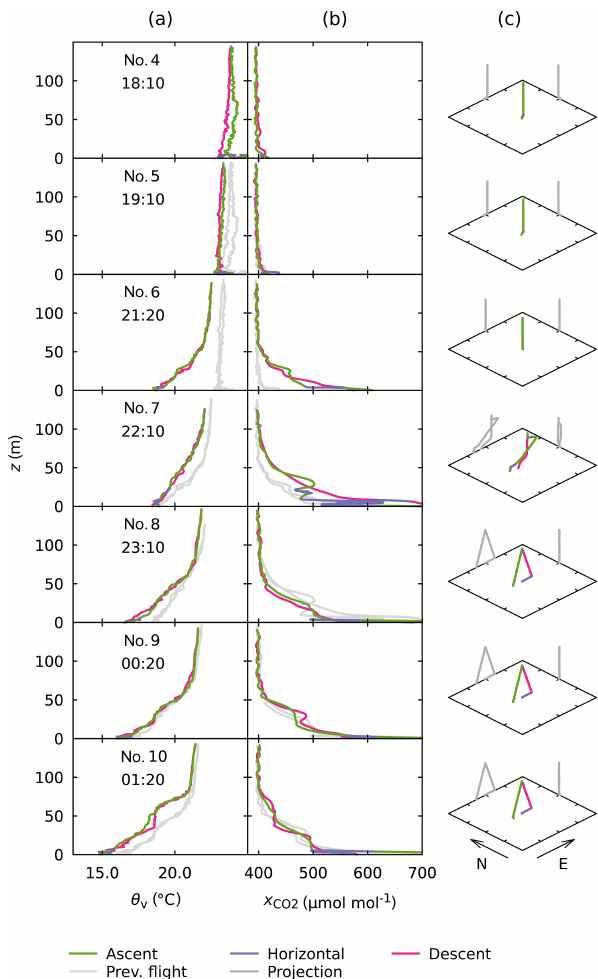
Figure 7. Profiles from flights 4 through 10, carried out in the night from 6 to 7 July 2016. Times are given in Coordinated Univer- sal Time and specify the middle of the flight, rounded to the next 10min. (a) Virtual potential temperature θ v at height above ground level z . (b) Carbon dioxide dry-air mole fraction x CO at height 2 above ground level z . To reduce noise x CO has been smoothed (for 2 details see text). In both (a) and (b) the light grey curves are copies of the previous profile (ascent, horizontal flight and descent com- bined). (c) Flight track with horizontal projections (grey) for clear- ness. The northward and eastward directions are marked. The tick marks at the ground plane are 100m apart. The location of take-off and landing differs slightly between flights, but all flights took place within the same 250m × 250m × 150m bounding box.